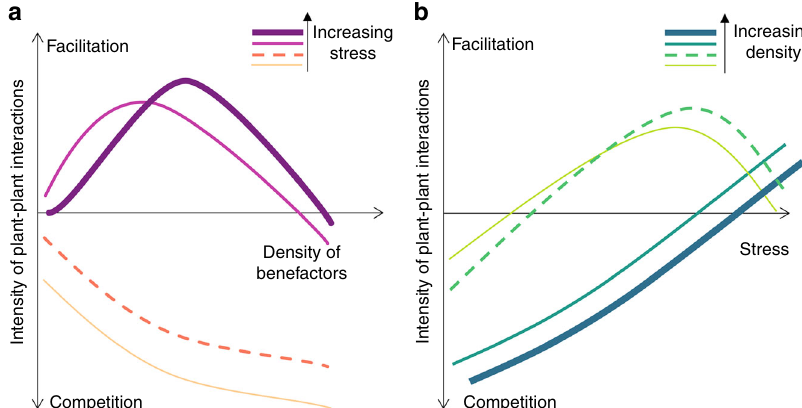
Fig. 1 The change of plant – plant interactions under stress. a How interaction intensity – density relationships should shift along a stress gradient and how the shift may affect the balance between facilitation and competition. Under low density (left of the intersection between the two highest stress levels), interactions become less negative with increasing stress but are not most positive for the highest stress level, whereas under high density, the shift in interaction intensity is continuous and follows the predictions of the stress-gradient hypothesis. b Same model as panel a but displaying how plant – plant interactions at differential densities change along a stress gradient. This shows that the SGH applies only to relatively high densities.